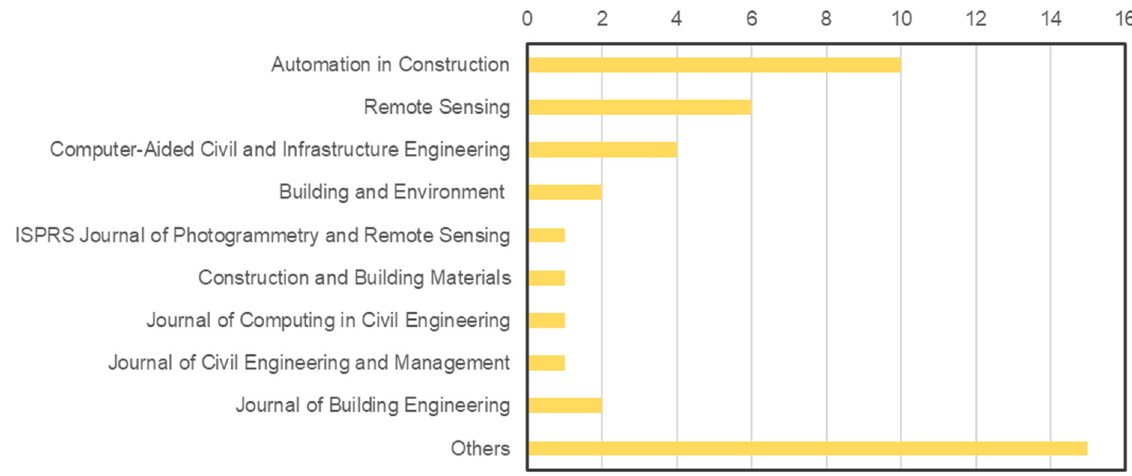
Figure 2. The number of articles that appeared in major journals.